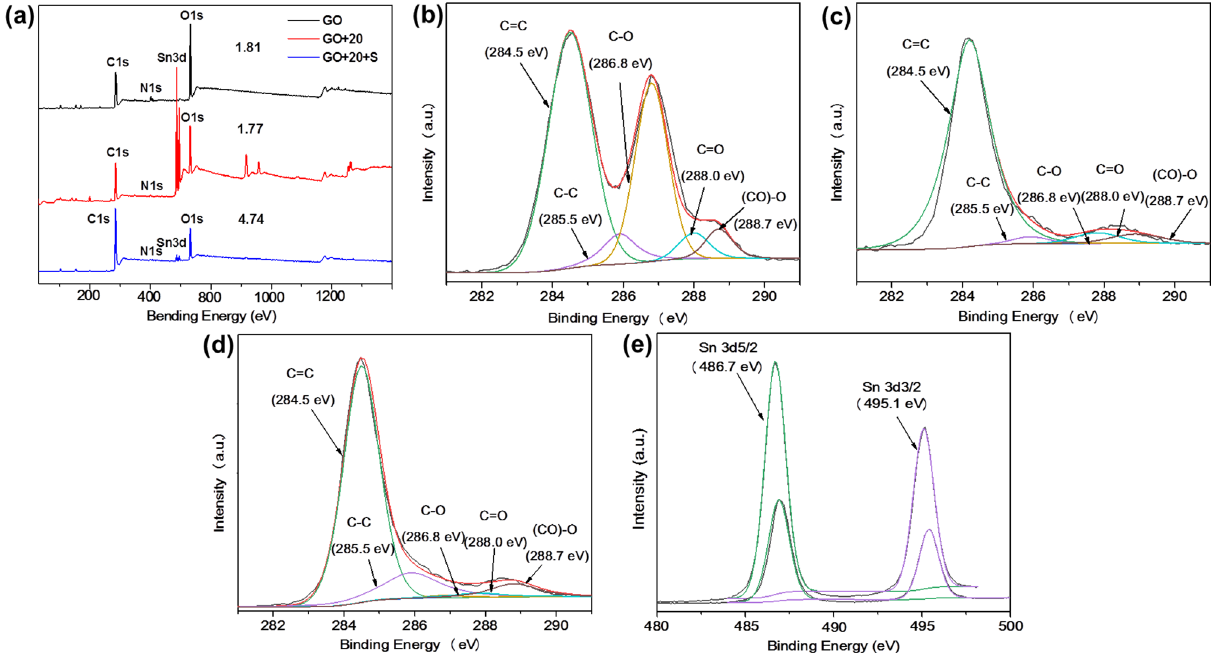
Figure 3. ( a ) XPS spectra of GO films after different treatments; ( b ) C1s spectra of unreduced GO films; ( c ) C1s spectra of GO films reduced twice by SnCl 2 for 10 min; ( d ) C1s spectra of GO films reduced twice by SnCl 2 for 10 min and treated by acid; ( e ) Sn 3 d spectra of GO films before and after acid